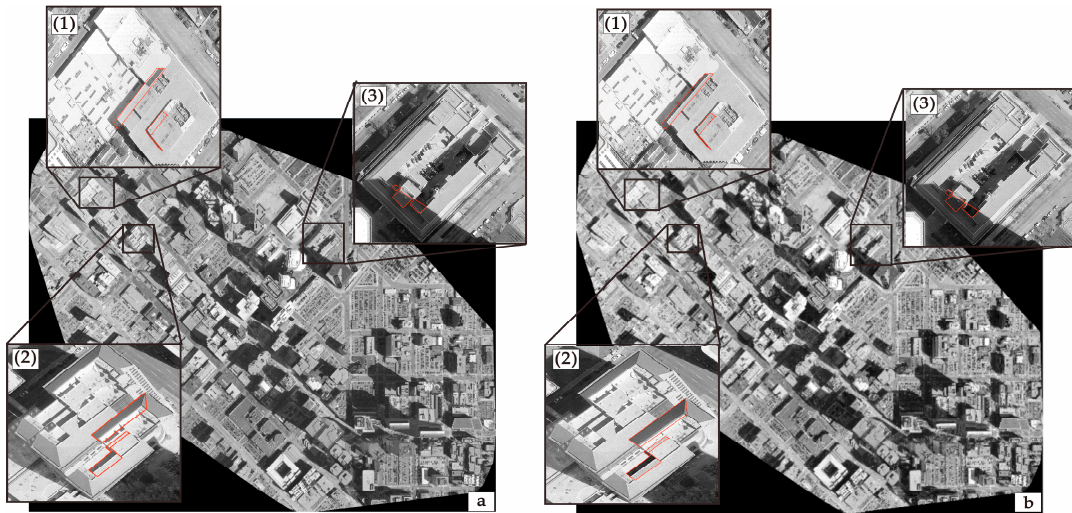
Figure 14. ( a ) is the shadow areas of ghost image that are not orthorectificated. ( b ) is the result of our method.